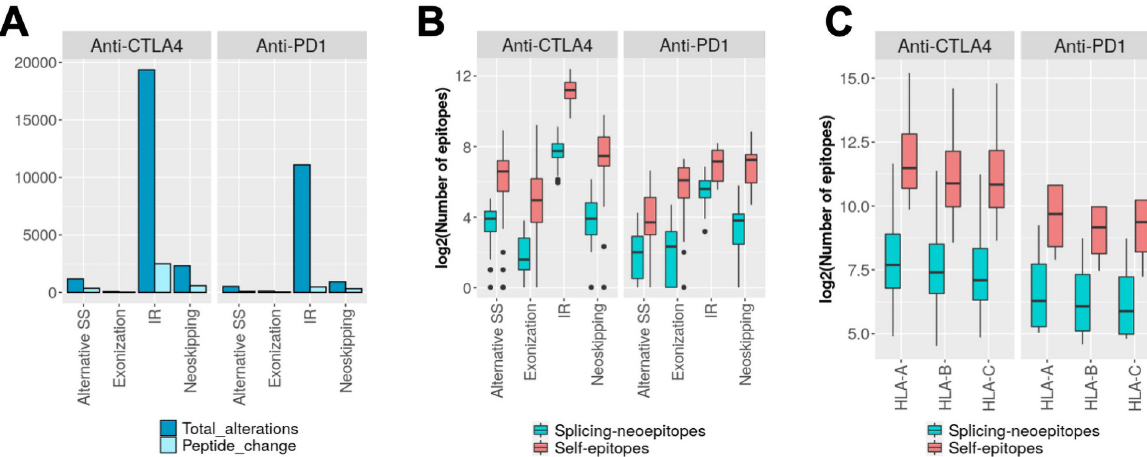
Fig 5. Splicing epitopes in two melanoma cohorts. (A) Total number of events and subset of protein-affecting events in the melanoma cohorts treated with anti-CTLA4 and with anti-PD1. (B) Distribution of the number of candidate tumor-specific splicing-derived neoepitopes (splicing- epitopes) and self-epitopes that would be depleted in the altered isoform (self-epitopes). (C) Distribution of the number of candidate epitopes from (B), separated by HLA-type.